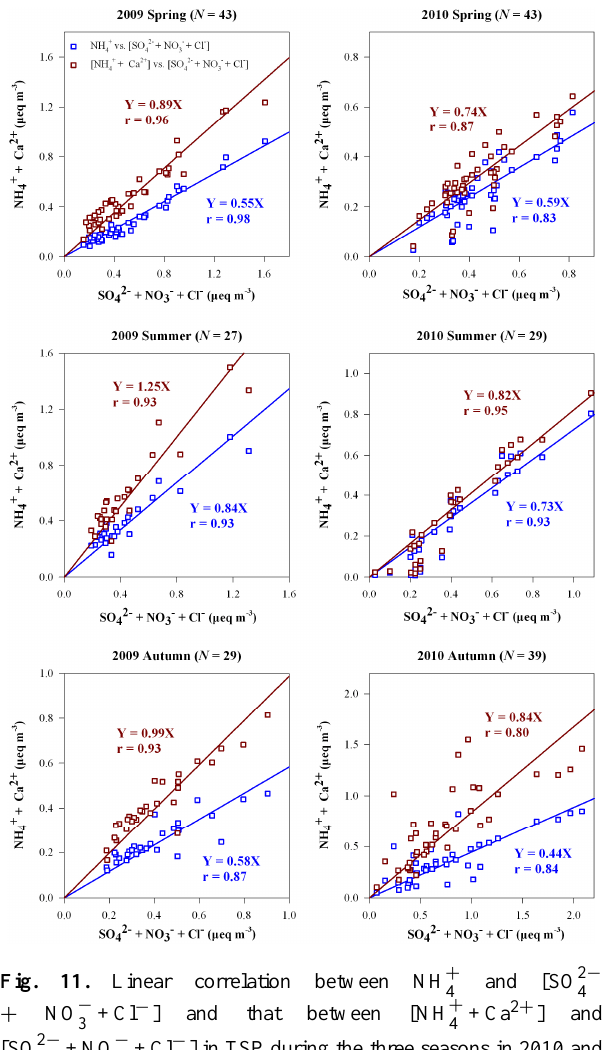
and [SO 2 − 4 4 +Ca 2 + ] and 4